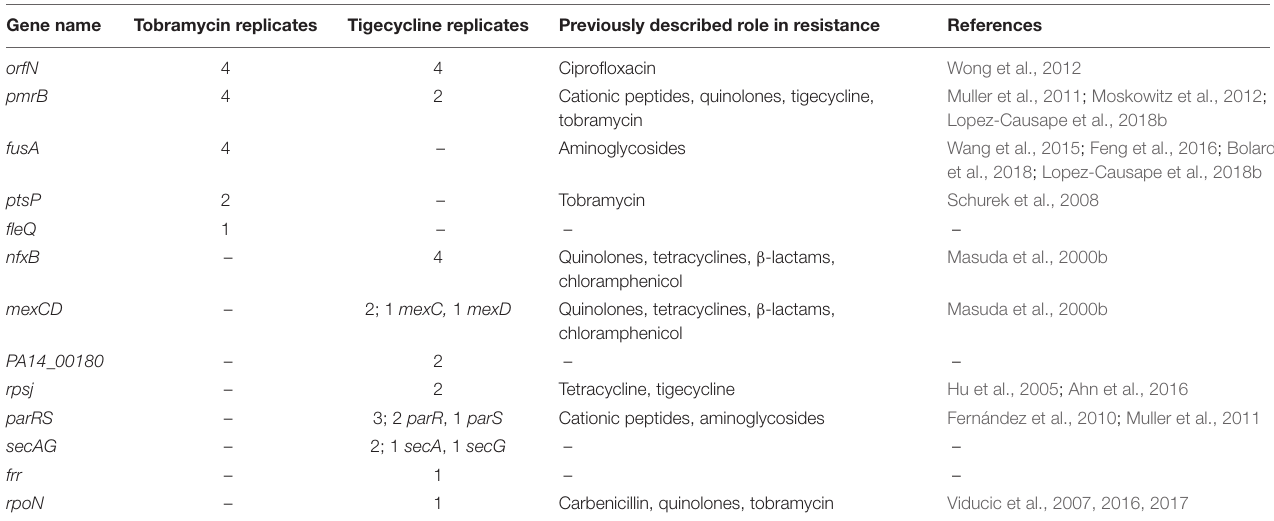
TABLE 2 | Previously described role on antibiotic resistance of genes presenting mutations in the evolved